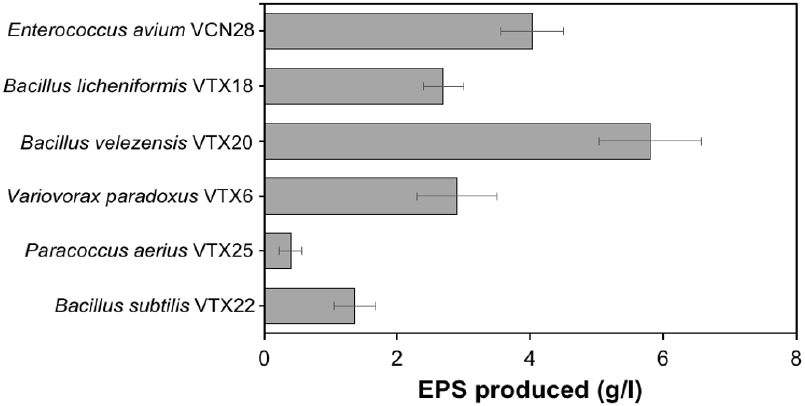
Figure 1. EPS production observed in six selected bacterial strains.